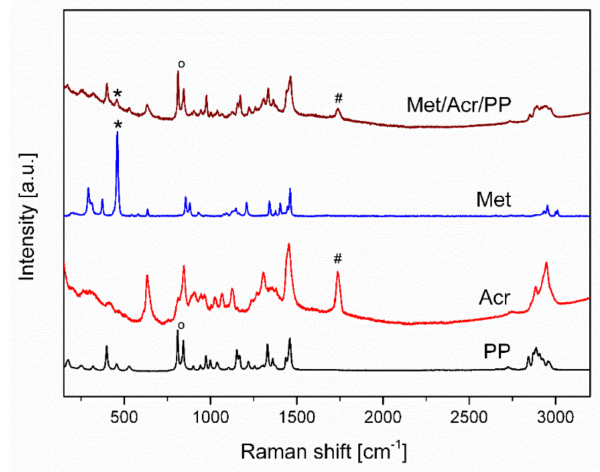
Figure 4. Raman spectra of PP mat modified with Acronal ® 500 D and metaldehyde and spectra of all constituents. O —peak of CH 2 wagging, CCH 3 stretching (809 cm − 1 ) and CC backbone stretching, CH 2 wagging, CCH 3 stretching and CH 3 bending (847 cm − 1 ) of PP, #—peak of the C=O stretching of Acr, *—peak for deformation vibration of epoxy compounds of Met. Samples acquisition parameters: power/integration time: PP: 1%/10 s; Acr: 1%/300 s; Met: 1%/10 s; Met/Acr/PP: 1%/120 s.